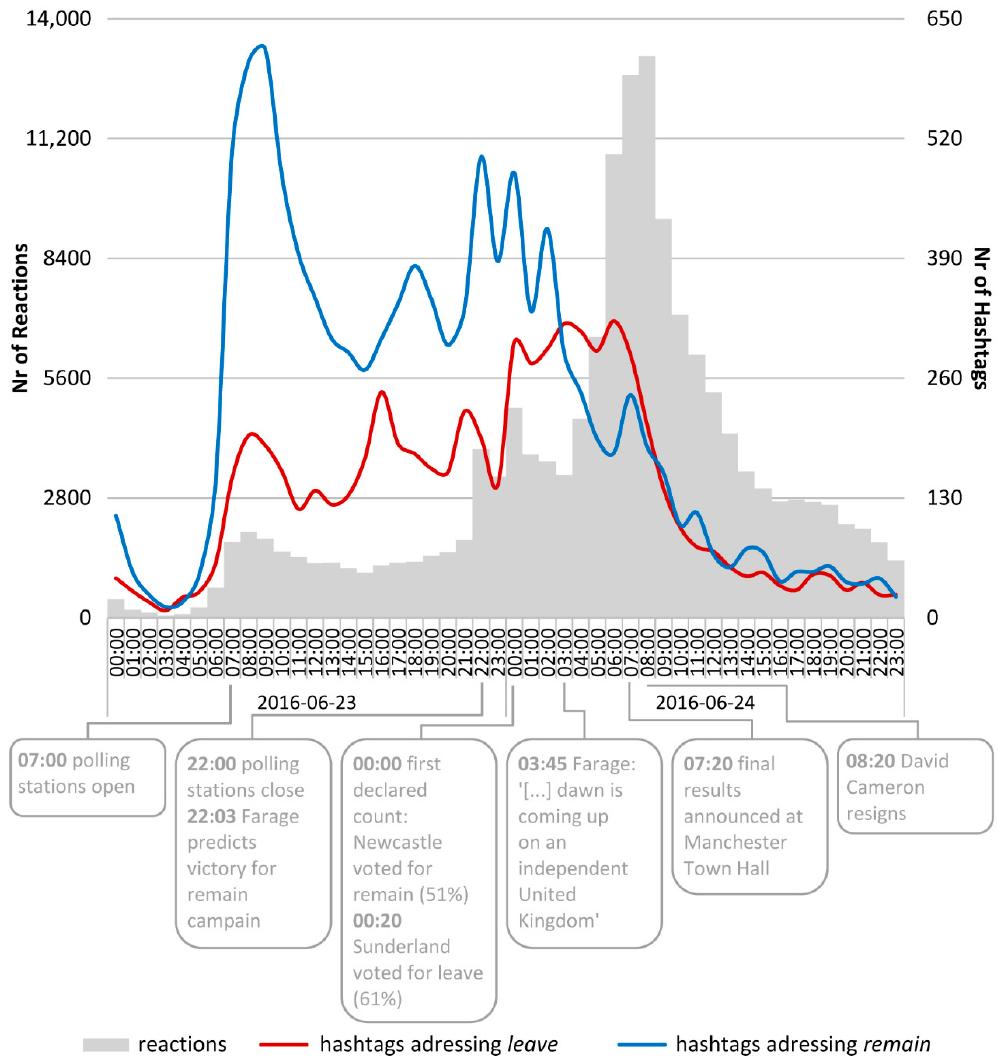
Figure 3. Number of total reactions to Brexit and the reactions that refer to leave or remain per hour on 23 and 24 June 23 and 24 June 2016.